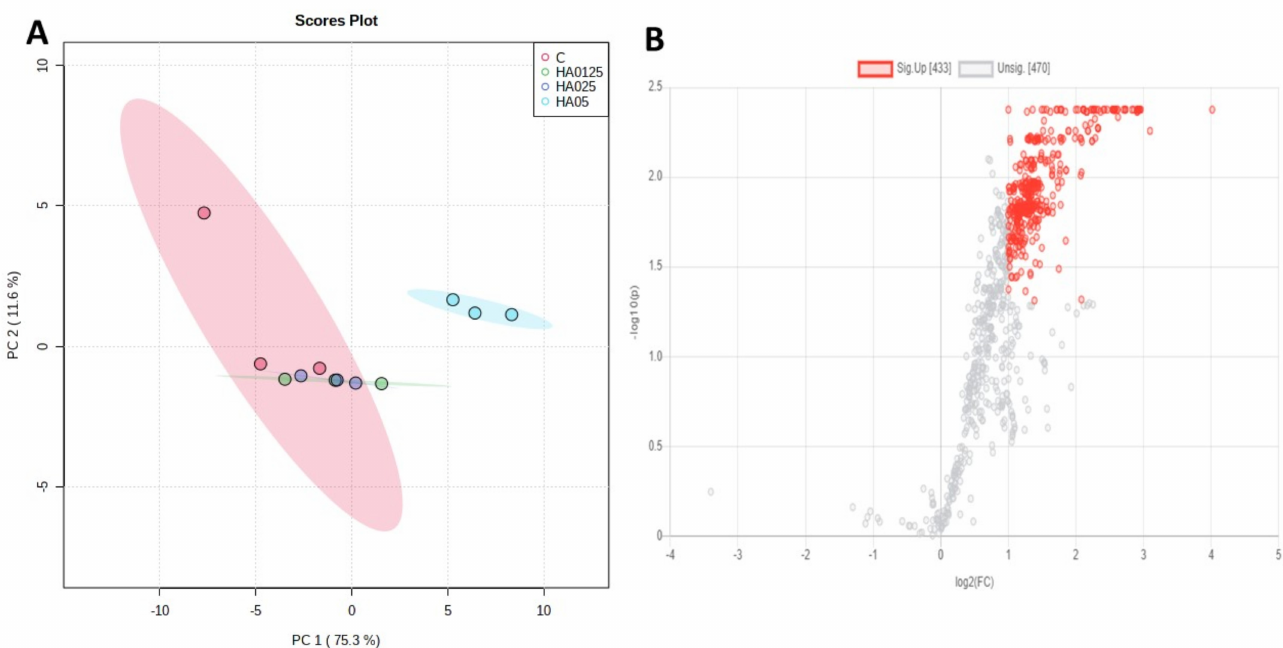
Figure 1. ( A ) Scoring plots reconstructed using PCA (PC1 vs. PC2). The red group corresponds to the control samples; green to those treated with 0.125% LMW-HA; violet to 0.25% LMW − HA and light blue to 0.50% LMW − HA treatment group; ( B ) Volcano Plot of LMW − HA 0.5% vs. C. In red the features significantly altered (fold change (FC) > 2, adjusted p -value < 0.05.